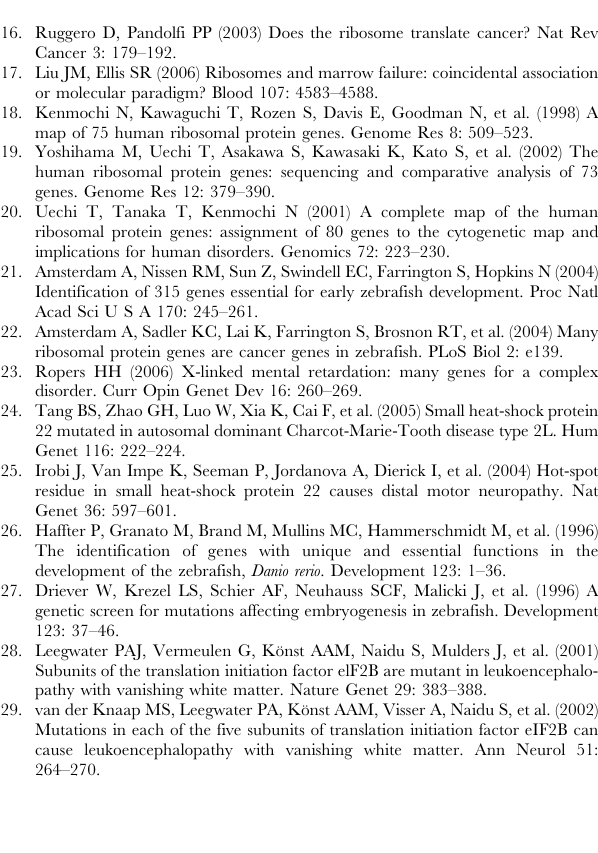
Figure S1 Rescued Embryos Co-Injected with the MO for rpl38 and Synthesized mRNA. Three days post fertilization embryos injected with the rpl38 MO (0.5 m g/ m l) displaying smaller head, shortened body and reduced yolk sac extension when compared